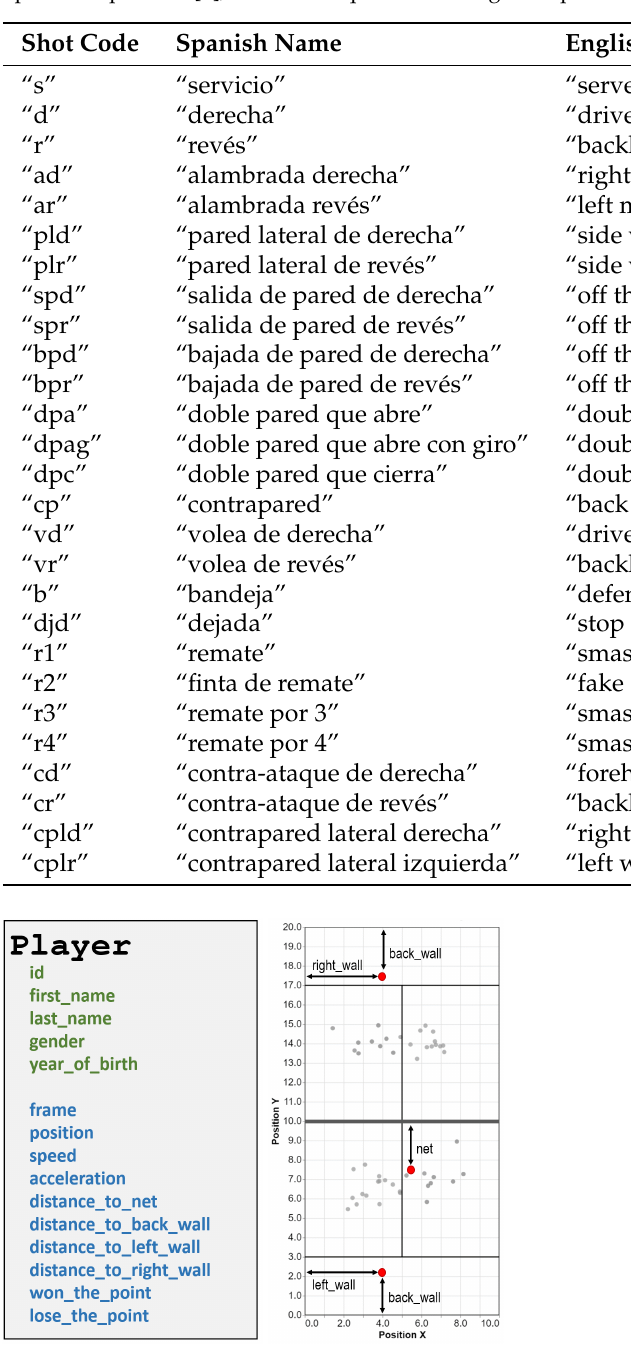
Table 6. Shot types with native support in our API. These shot types are based on the classification proposed in [5] (except the serve). Each row corresponds to a shot type. We provide the shot code, its Spanish expansion [5], and some equivalent strings to represent them in queries.